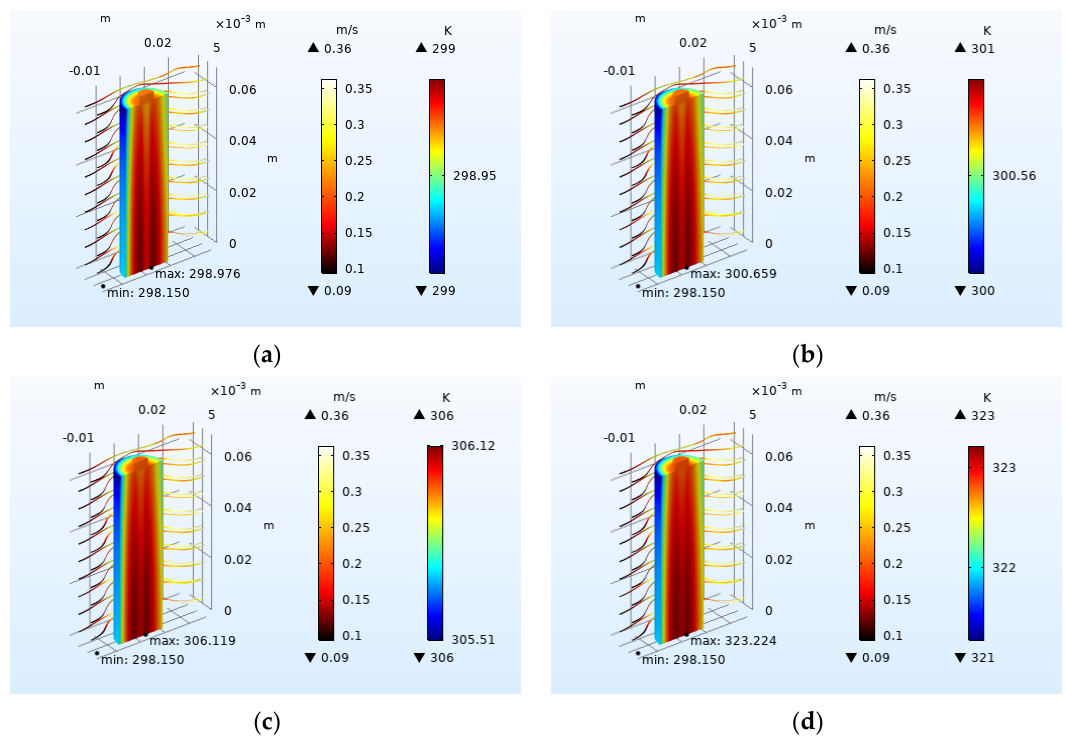
Figure 8. Internal temperature distribution of batteries with different rates. ( a ) 0.5 C charge–discharge rates; ( b ) 1 C charge–discharge rates; ( c ) 2 C charge–discharge rates; ( d ) 4 C charge–discharge rates.